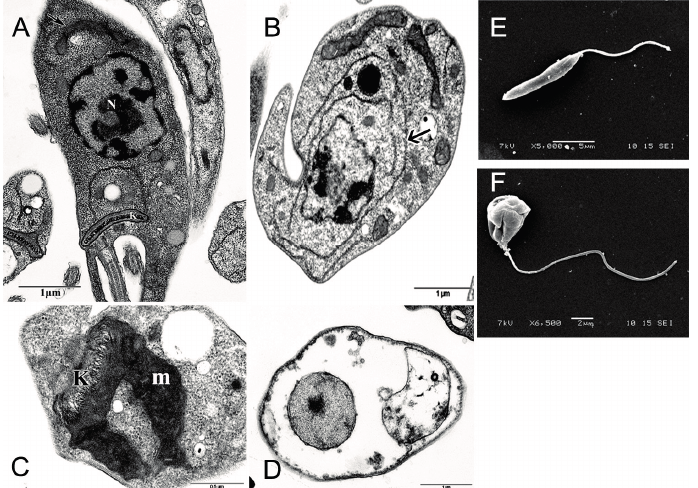
Figure 5. Effect of DME on the parasite ultrastructure as observed by transmission ( A – D ) and scanning ( E , F ) electron microscopy; (A) A control promastigote form showing a morphologically preserved mitochondrion (arrow), nucleus (N) and kinetoplast (K); (B) Promastigote forms treated with IC DME. Note the presence of endoplasmic 50 reticulum profiles (arrow) surrounding the organelles; (C) High magnification of mitochondrion (m) of a promastigote treated with IC DME; (D) Drastically damaged 50 promastigote treated with 2 × IC DME; (E) Scanning electron microscopy of a control 50 DME-treated promastigote and (F) 2 × IC 50